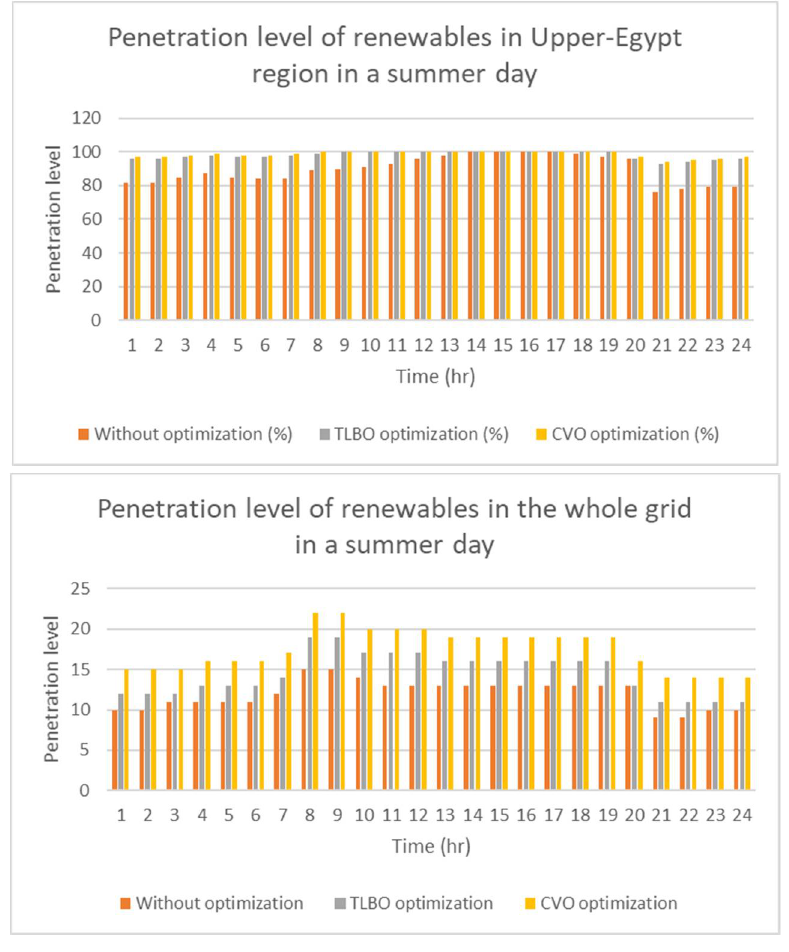
Figure 6. Penetration level of renewable energies in the Upper-Egypt region and the whole Egyptian grid in a summer day.